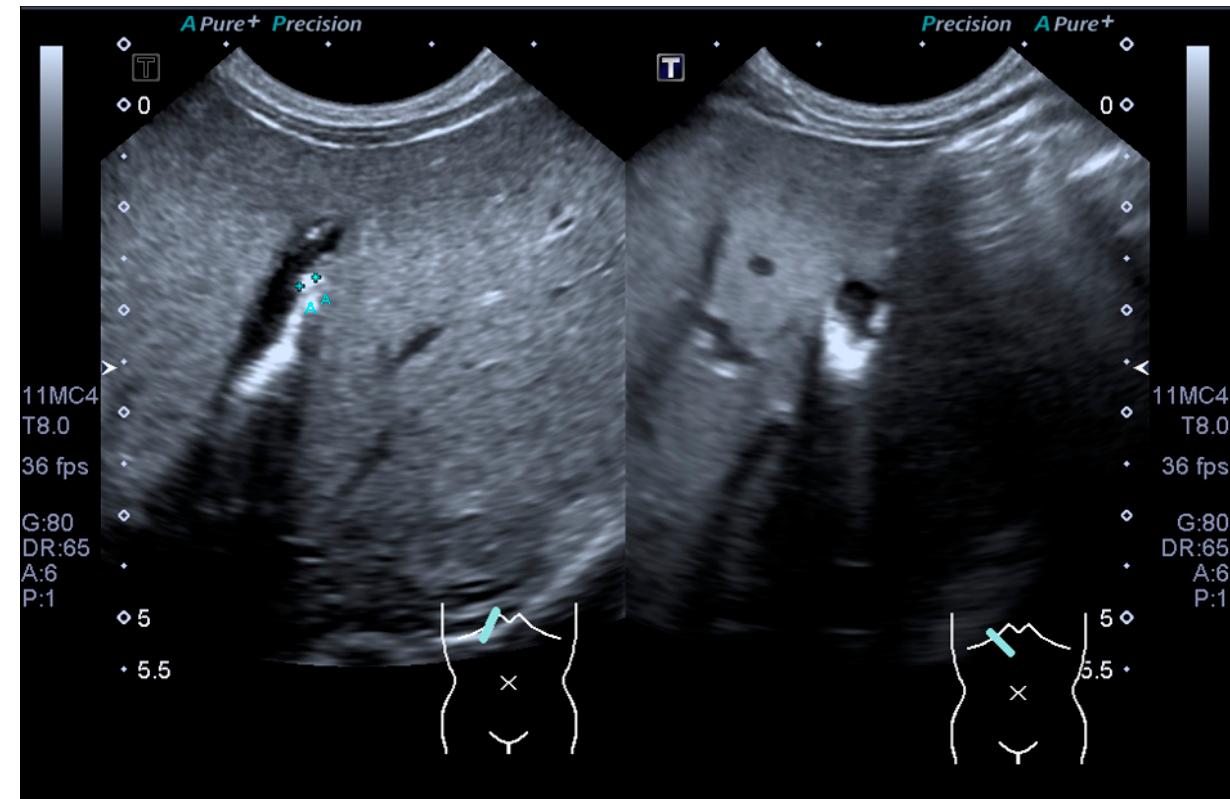
Figure 1. Ultrasound picture showing multiple echogenic foci within the gallbladder with posterior shadowing suggestive of sludge.